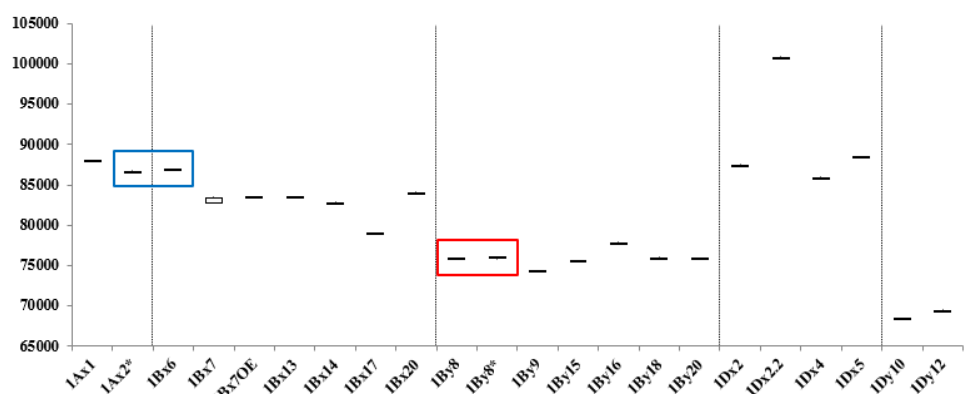
Figure 4. Box and whisker plot of molecular weights of individual subunits in standard wheat cultivars. Red and blue boxes indicate subunits differing by less than 300 Da that were not distinguished by MALDI-TOF-MS, but could be differentiated by RP-HPLC.